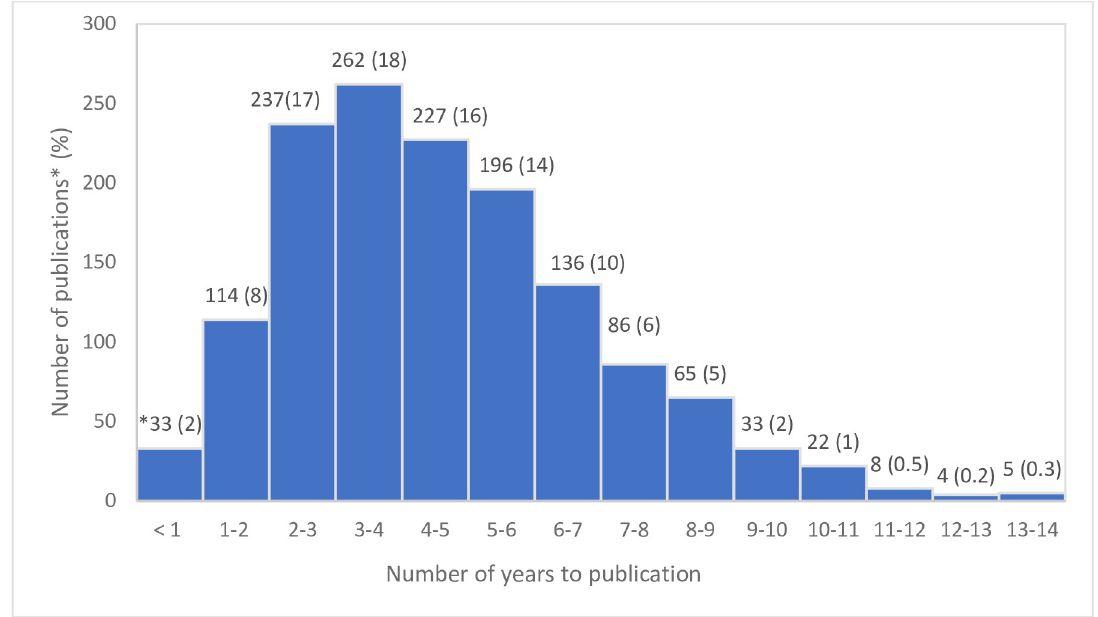
Fig 3. Number of years from the date of first participant enrolment to publication, including prospective and retrospective registrations (n = 1,428). � one conference abstract was not included in the analysis due to publication before the anticipated start date.